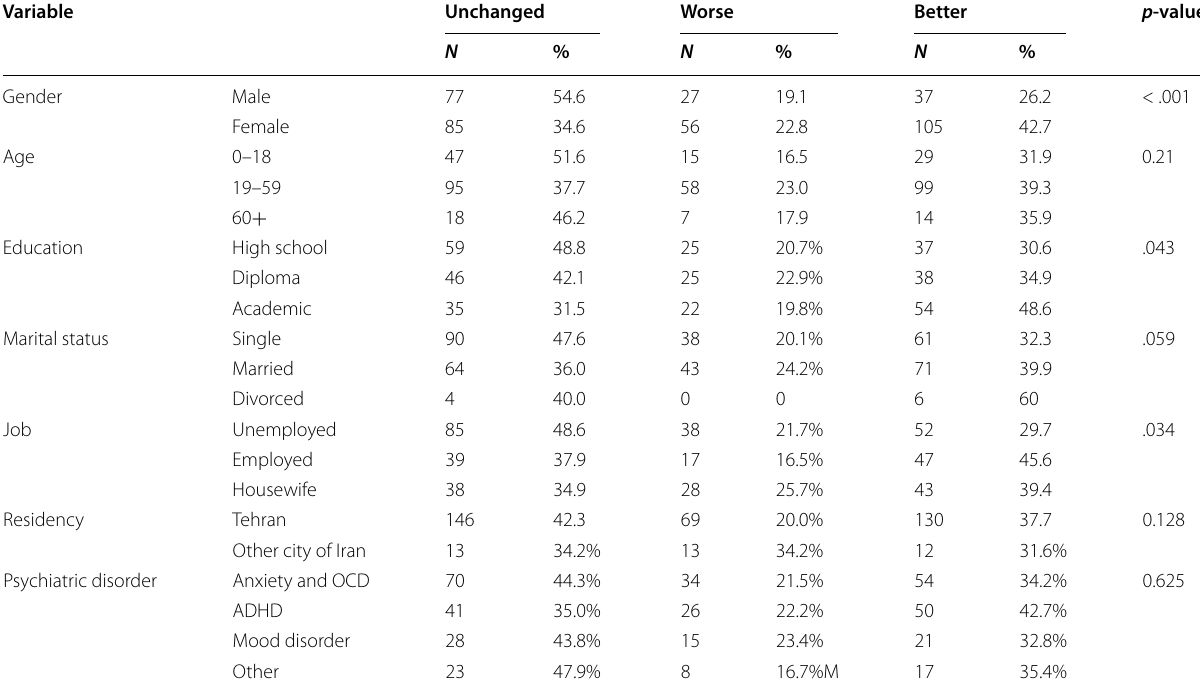
Table 2 Change in disease status during the epidemic in terms of demographic and contextual variables Variable